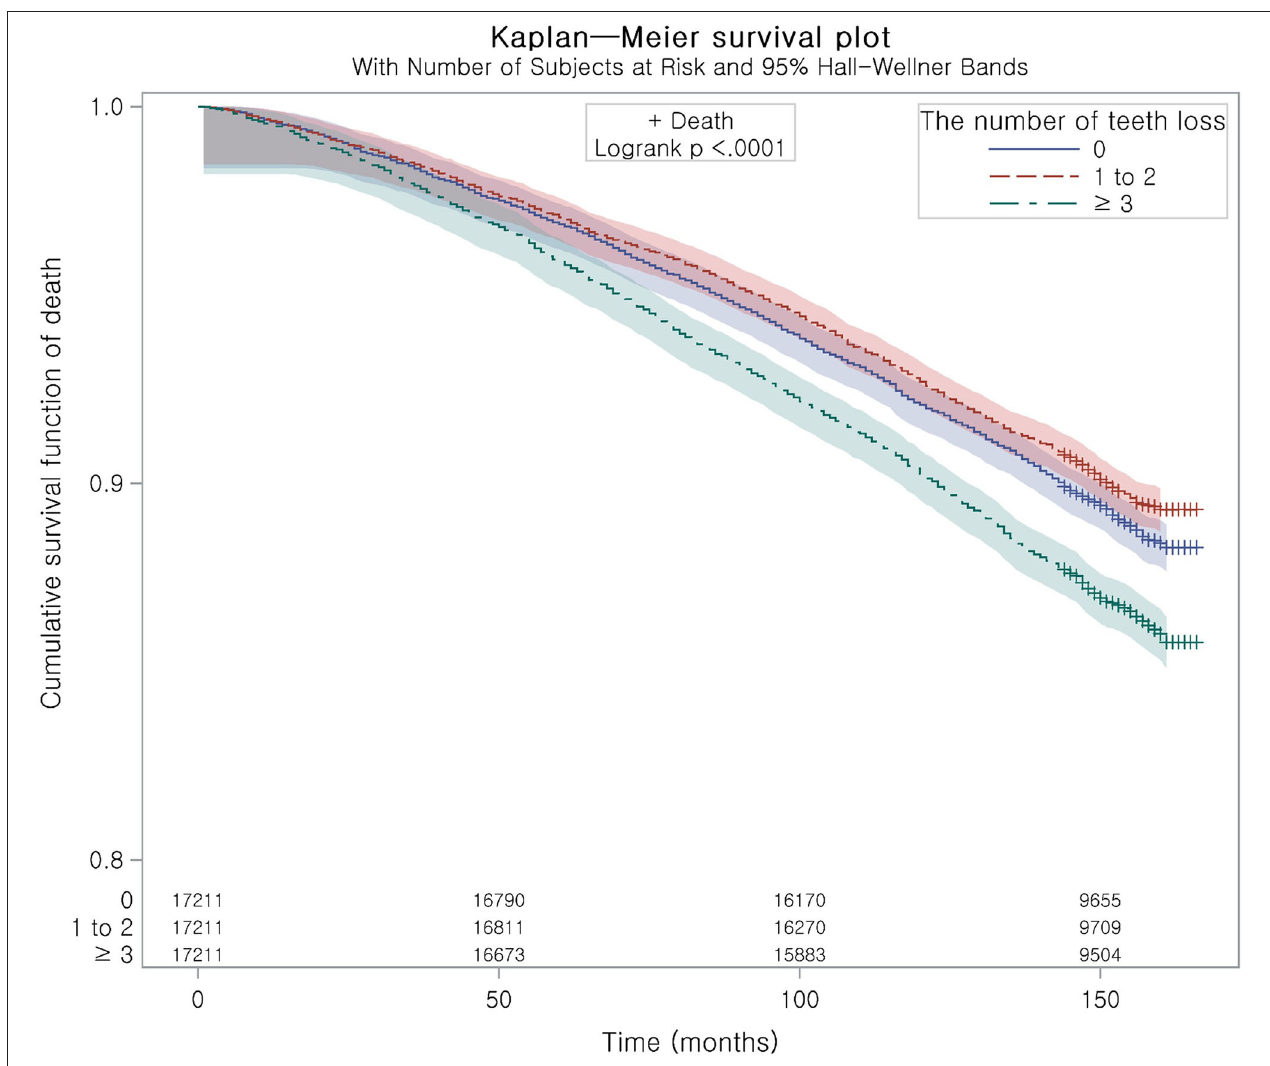
FIGURE 3 | The Kaplan–Meier curve of mortality according to the number of missing